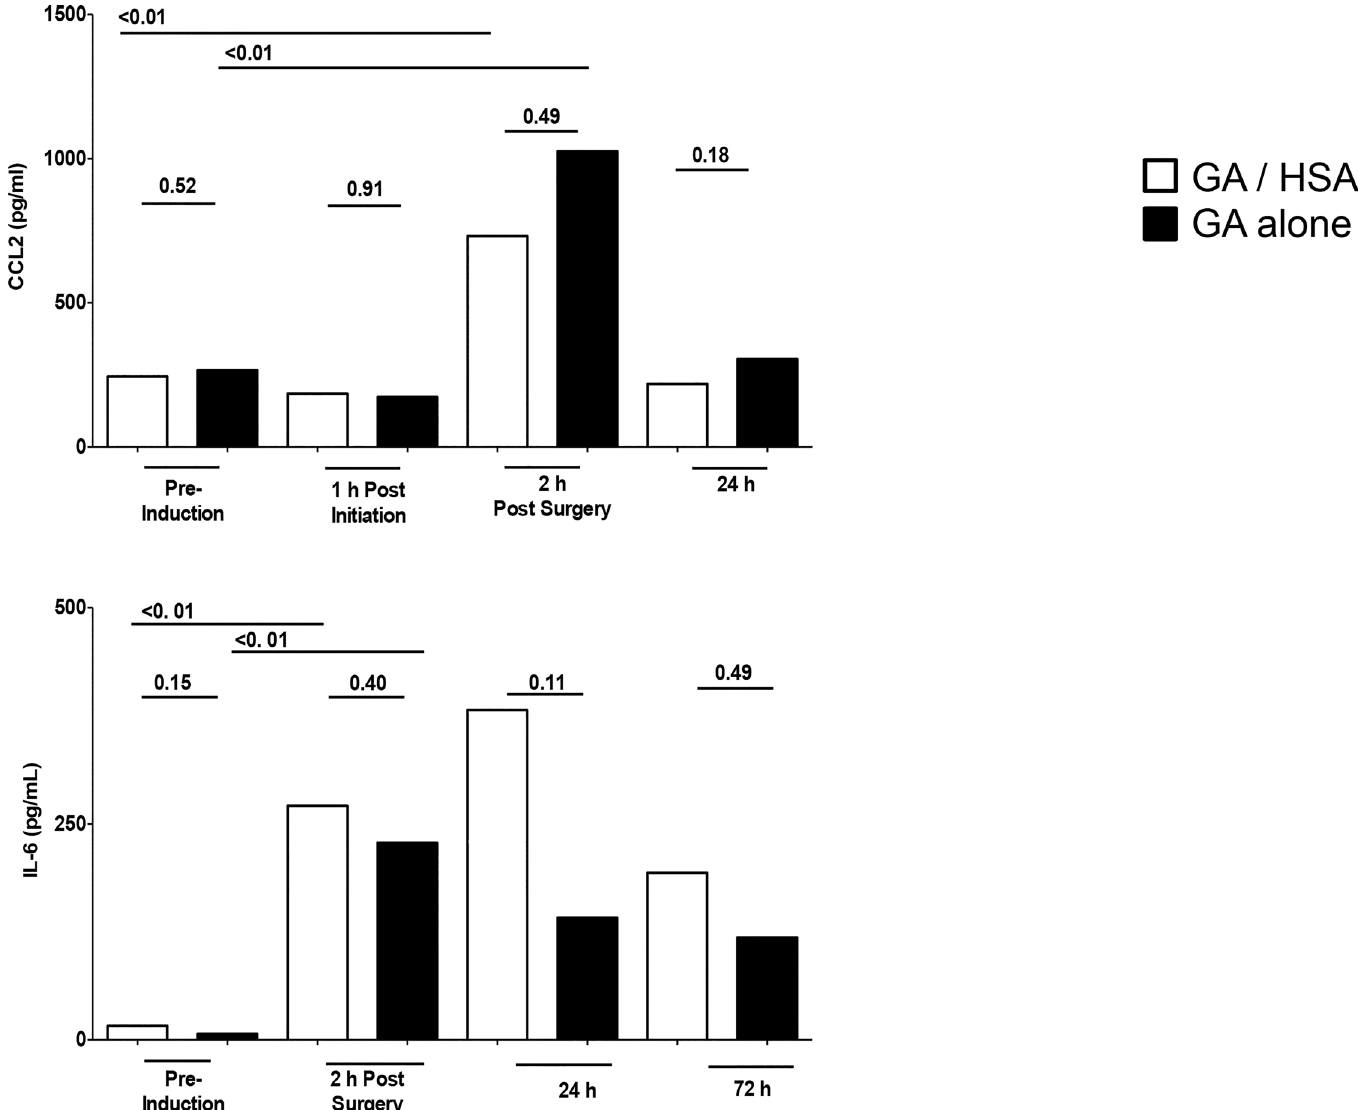
Fig 3. Magnitude and duration of systemic pro-inflammatory cytokine responses in individuals receiving supplemental HSA. Median values are shown for groups receiving HSA plus general anesthetic (open bars) or general anesthetic alone (solid bars). P values reflect inter-group comparisions using Mann-Whitney at the time points